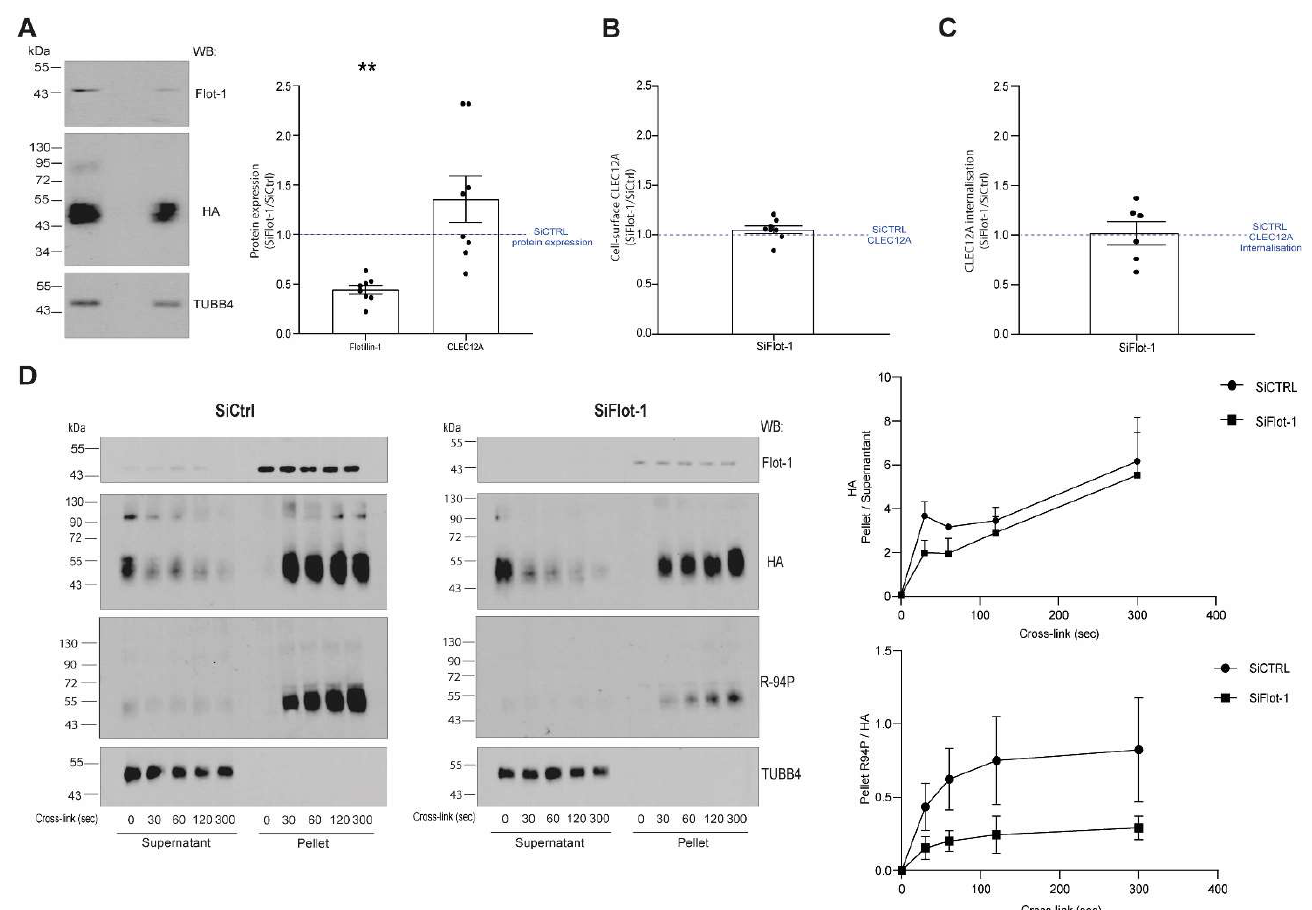
Figure 8. Flotillin depletion downregulates antibody-induced CLEC12A phosphorylation. ( A ) Flotillin-1 expression was knocked-down with a pool of flotillin-1-specific siRNAs (siFlot-1) in HEK-293T cells transiently transfected with CLEC12A WT. The diminution of flotillin-1 expression was confirmed by Western blot as was CLEC12A expression. ( B ) Cell-surface CLEC12A expression in flotillin knocked-down cells was compared to cells transfected with control (siCTRL) siRNAs by flow cytometry with an anti-HA antibody. The ratio of the MFI of the anti-HA signal in siFlot-1/siCTRL RNA-treated cells is shown in the graph. Data in ( A , B ) are representative of eight independent experiments. ( C ) The effect of SiFlot-1 on CLEC12A internalisation was determine by flow cytometry as described in ‘Materials and Methods’. Data are shown as the ratio of the median fluorescent index (MFI) of cell-surface CLEC12A in siFlot-1 cells/siCTRL cells after the antibody-induced internalisation of CLEC12A. These data are representative of eight independent experiments. ( D ) CLEC12A was cross-linked with the anti-HA antibody on HEK-293T cells transiently expressing WT CLEC12A and transfected with siFlot-1 or siCTRL siRNAs. CLEC12A translocation to the NP40-insoluble pellet and phosphorylation was analysed by Western blot of the supernatant (SN) and pellet (P) of cell lysates with the anti-HA and R-94P antibody. The anti-TUBB4 (tubulin 4) antibody was used as a loading control. These data are representative of four and three (for R-94P) independent experiments. Densitometric analysis was performed on the anti-HA data to calculate the ratio of CLEC12A in the pellet/supernatant in siFlot-1 and siCTRL siRNA-transfected cells (top graph) . The proportion of phosphorylated CLEC12A in the pellet is shown as the ratio of phosphorylated CLEC12A (R-94P) /non-phosphorylated CLEC12A (anti-HA) in siFlot-1 and siCTRL siRNA-transfected cells (bottom graph) . ( C ) Statistical analysis: One sample Wilcoxon test ** p < 0.01.